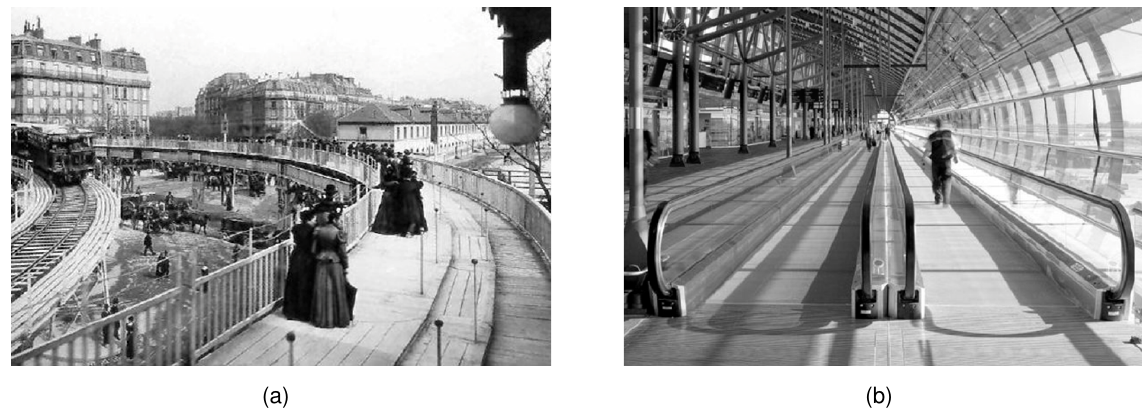
Figure 1. Moving walkways. (a) historical MW at the Exposition Universelle in Paris, 1900, composed of two parallel lanes with increasing speed. (b) modern MW installed in a transportation hub. Adapted from Avenel (1900) and Otis